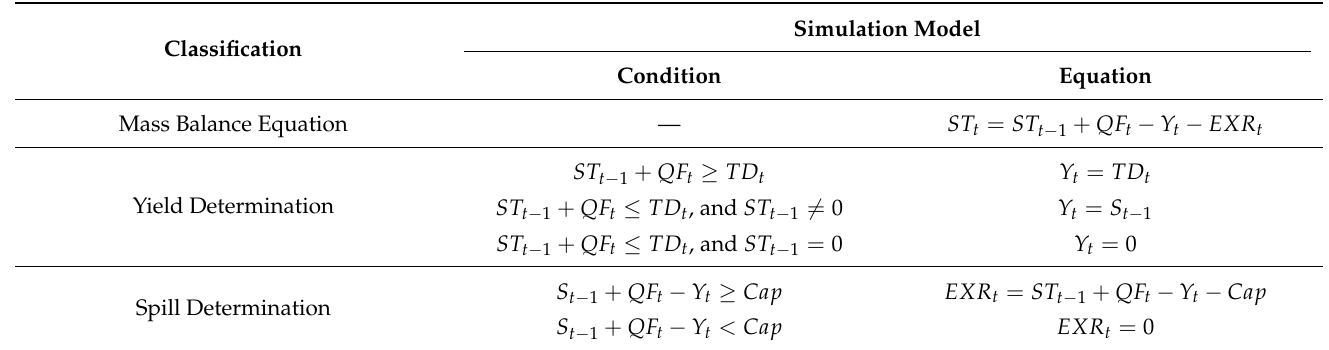
Table 4. The equations for the simulation model for rainwater harvesting systems.